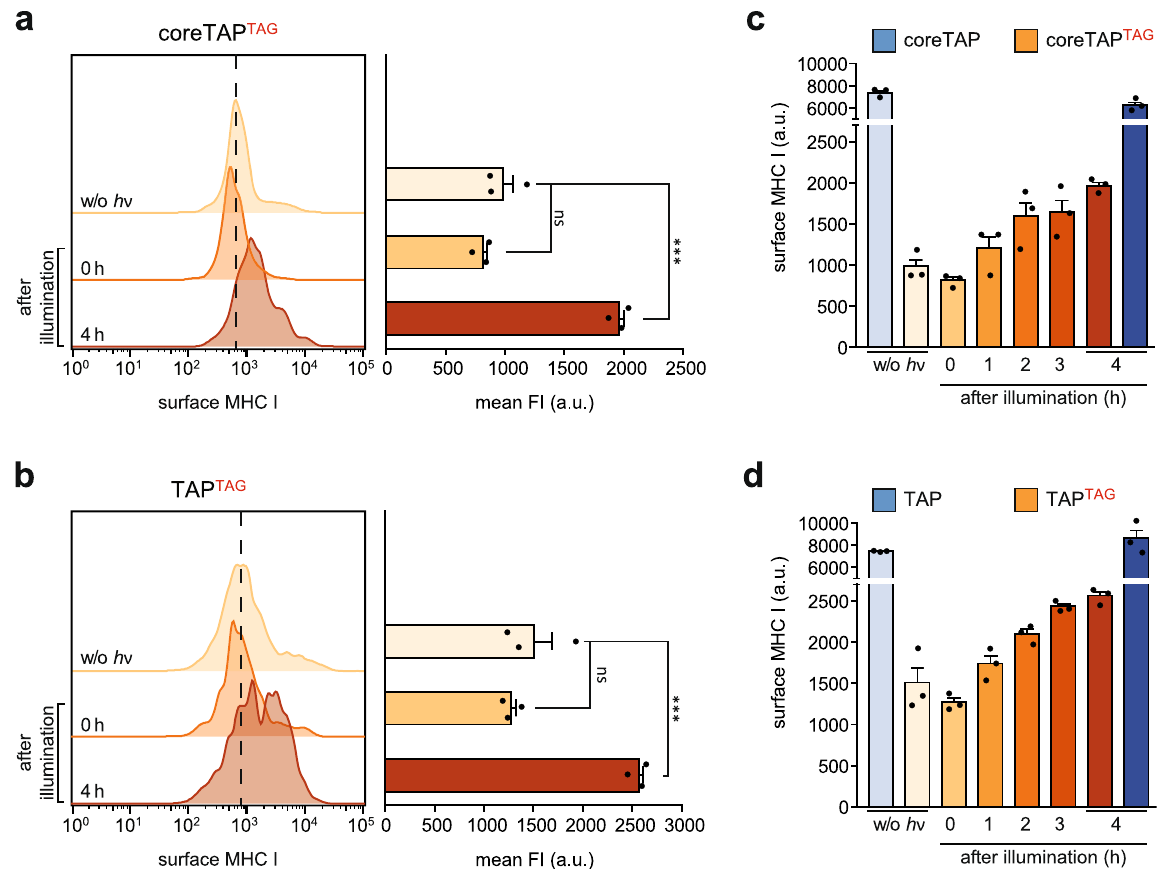
Fig. 5 Light activation of TAP synchronizes MHC I traf fi cking and surface presentation. a coreTAP TAG /PCK and b TAP TAG /PCK was expressed in TAP2- de fi cient STF1-169 cells. MHC I surface expression of the mVenus-positive cells was monitored before (w/o h ν ) and after illumination by fl ow cytometry using an APC-Fire750-labeled HLA-A, B, C-speci fi c antibody (W6/32). The black dotted line represents the mode FI of non-illuminated cells. Mean FI was calculated (±SEM, n = 3, biologically independent samples) and a One-way ANOVA with Turkey ’ s multiple comparison test was performed. ns non- signi fi cant; ***, p < 0.0001. c coreTAP TAG /PCK- and d TAP TAG /PCK-dependent MHC I surface expression (± SEM, n = 3, biologically independent samples) up to 4 h after illumination. FI fl uorescence